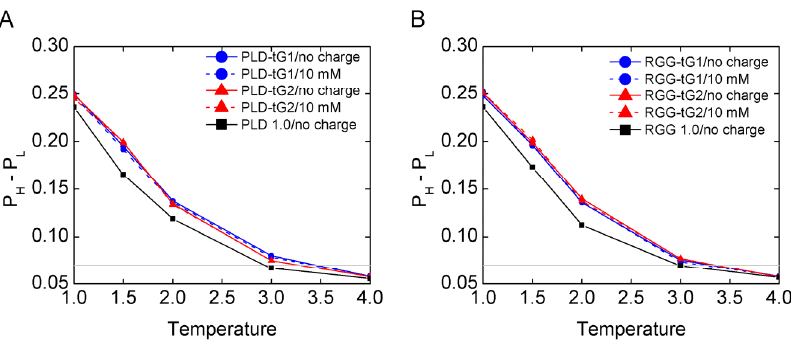
Figure 2. P H − P L of PLD-tG ( A ) and RGG-tG ( B ) in different solvents changes with temperature when ε -insert=0.00001 kJ/mol. The P H and P L values are calculated with the last 1000 τ simulation data as P H − P L of all the simulations reaches equilibrium after 3000 τ (see Figures S4–S7). The gray line is P H − P L = 0.07.